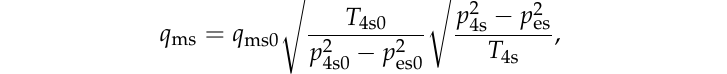
Figure 2. Schematic of steam – water system in a typical CHP plant.